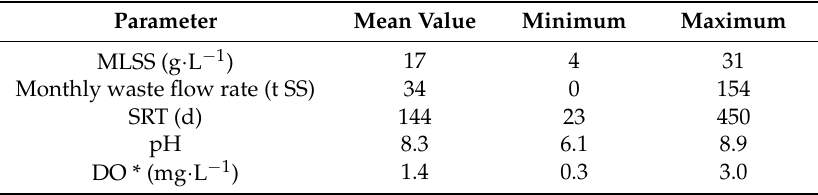
Table 2. Main operating parameters of the oxidation/nitrification tank (data from 2012 to 2017).